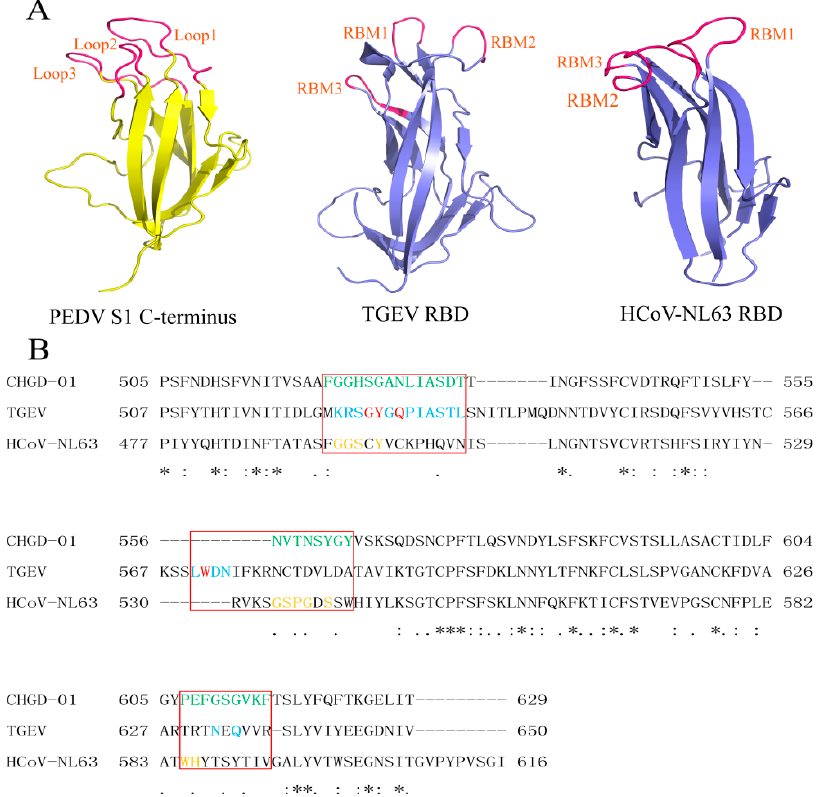
Figure 4. Structural and sequence comparison between the PEDV S1 C-terminus and the TGEV and HCoV-NL63 RBDs. ( A ) Structural comparison of the PEDV S1 C-terminus ( left ), TGEV RBD ( middle ), and HCoV-NL63 RBD ( right ). The PEDV S1 C-terminus is shown in yellow, the TGEV and HCoV-NL63 RBDs are shown in slate, and the motifs responsible for receptor binding are marked in hot pink; ( B ) Structure-based sequence alignments of the PEDV S1 C-terminus, TGEV RBD, and HCoV-NL63 RBD. Residues boxed in red are RBMs for TGEV and HCoV-NL63 or are predicted RBMs for PEDV; these motifs correspond to the three loops at the tips of the β -barrel domains of the three coronaviruses. PEDV mutated residues are colored in green. TGEV RBD and pAPN residues in close contact are marked in cyan, and those engaged in hydrogen bonding are shown in red. Residues on HCoV-NL63 RBD that are in direct contact with ACE2 are marked in orange.